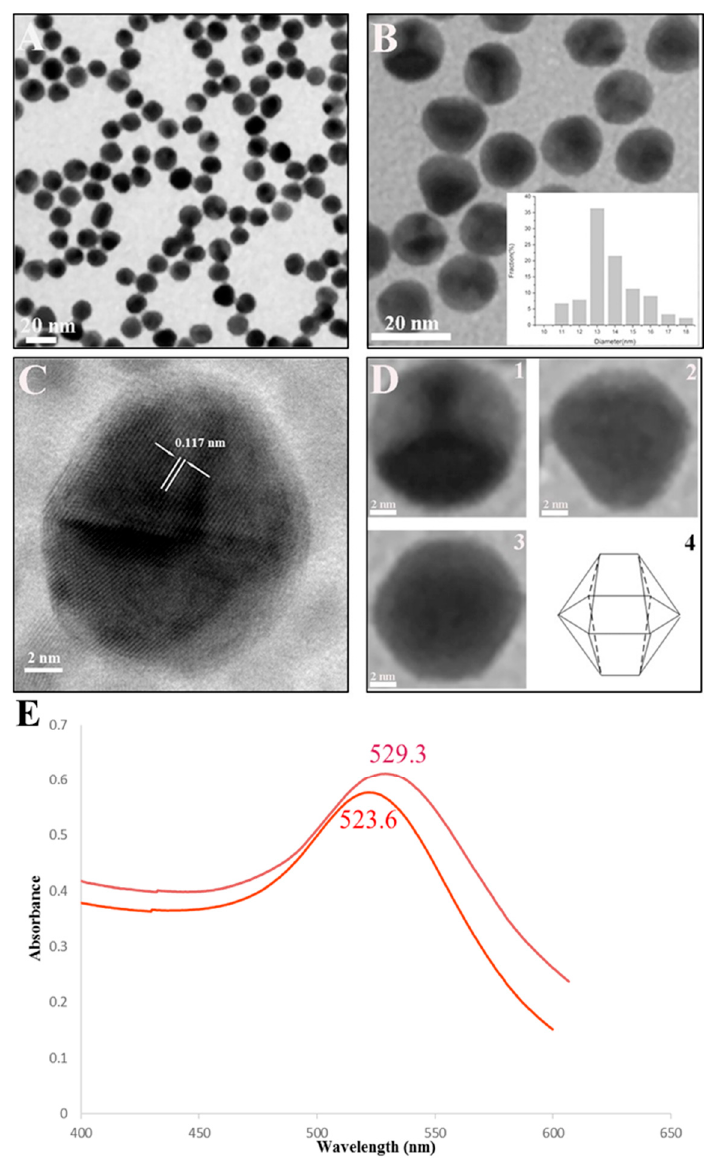
Figure 1. Characterization of colloidal gold. ( A ) TEM image of gold nanoparticles (AuNPs) (100,000× magnification); ( B ) TEM image of AuNPs (500,000× magnification). The size distribution of the AuNPs magnification); ( B ) TEM image of AuNPs (500,000 × magnification). The size distribution of the